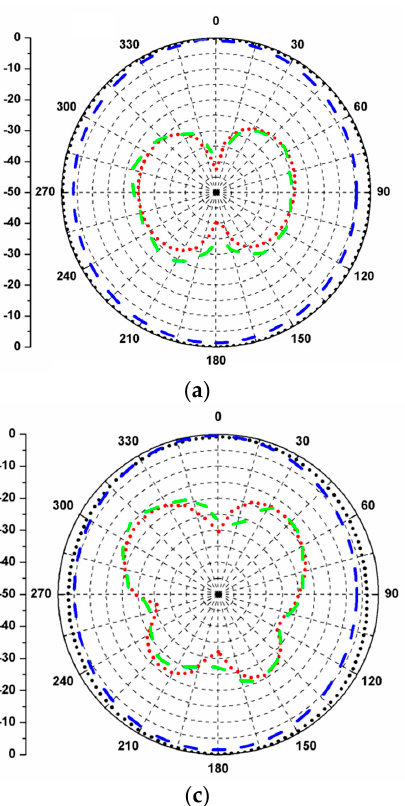
Figure 10. Proposed quadruple band-notched SWB antenna: ( a ) efficiency, ( b ) group delay.